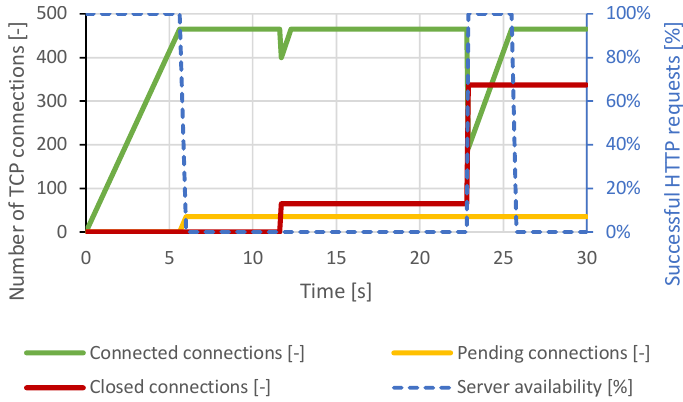
Figure 3. Slowloris attack against Apache